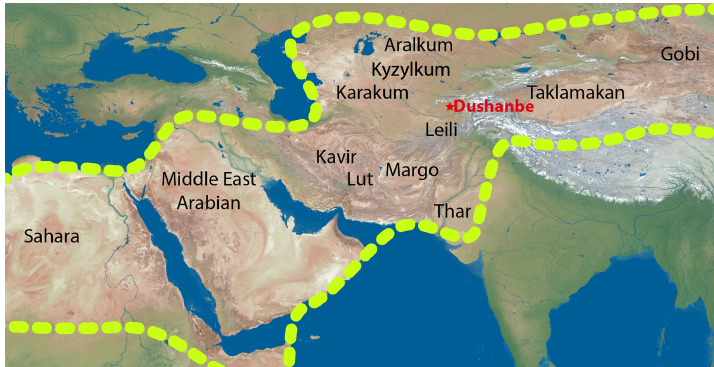
Figure 1. Geographical map with desert regions (black text), dust belt (bright green dashed line), measurement site in Dushanbe, Tajikistan (red text) highlighted (http://naturalearth.springercarto.com,